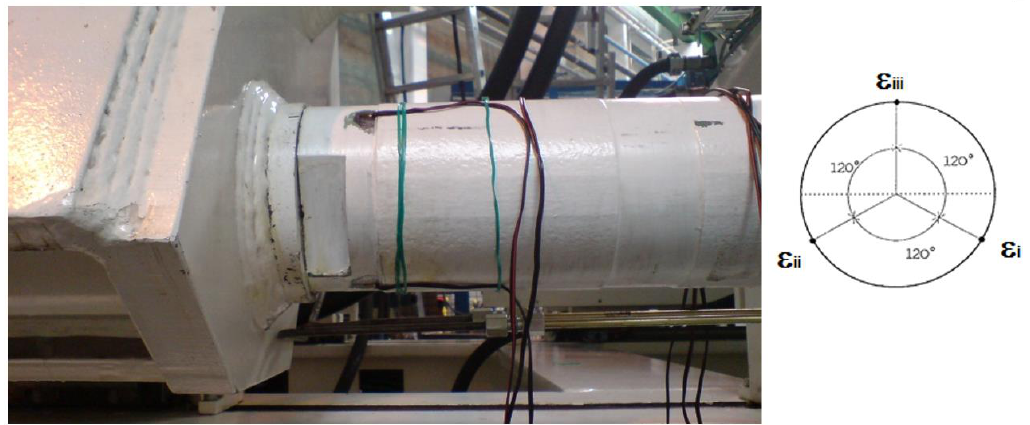
Figure 5. Deployment of strain gauges along the outer cross-sectional area of the guide bar. The measured typical stresses in the critical cross-section on the outer surface of the guide bar are displayed in Figure 6.